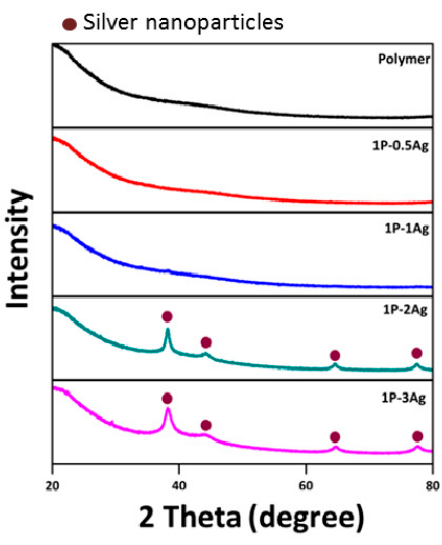
Figure 5. X-ray diffractograms of the polymer A and its corresponding nanocomposites at different ratios of silver.